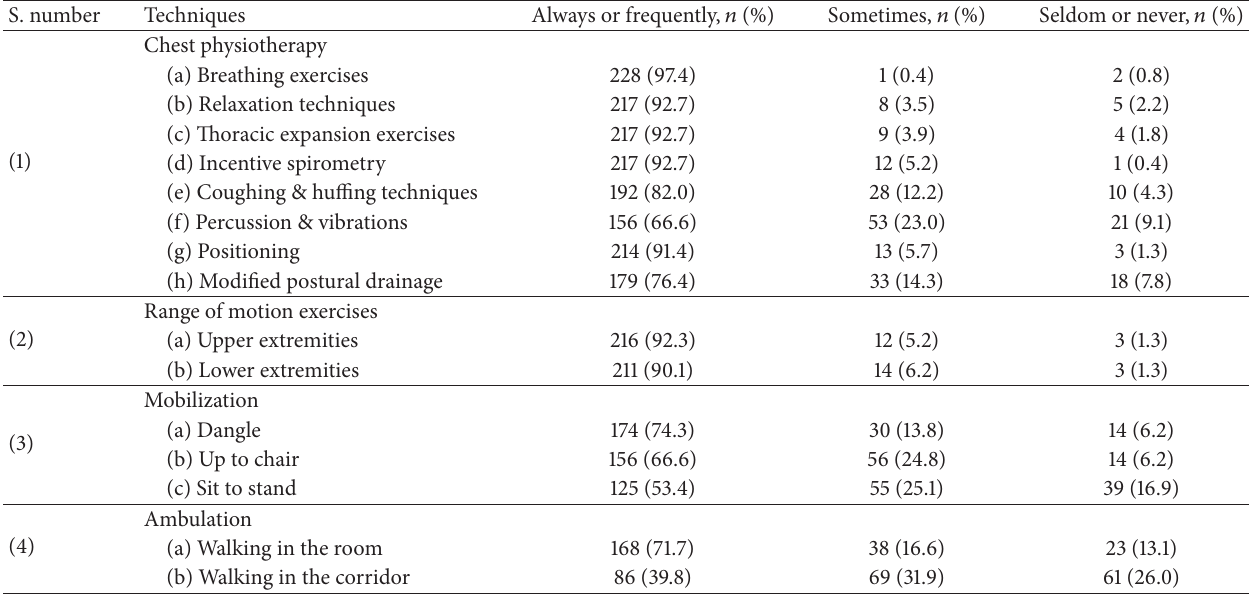
Table 6: Physiotherapy interventions used on the 2nd postoperative day. S. number